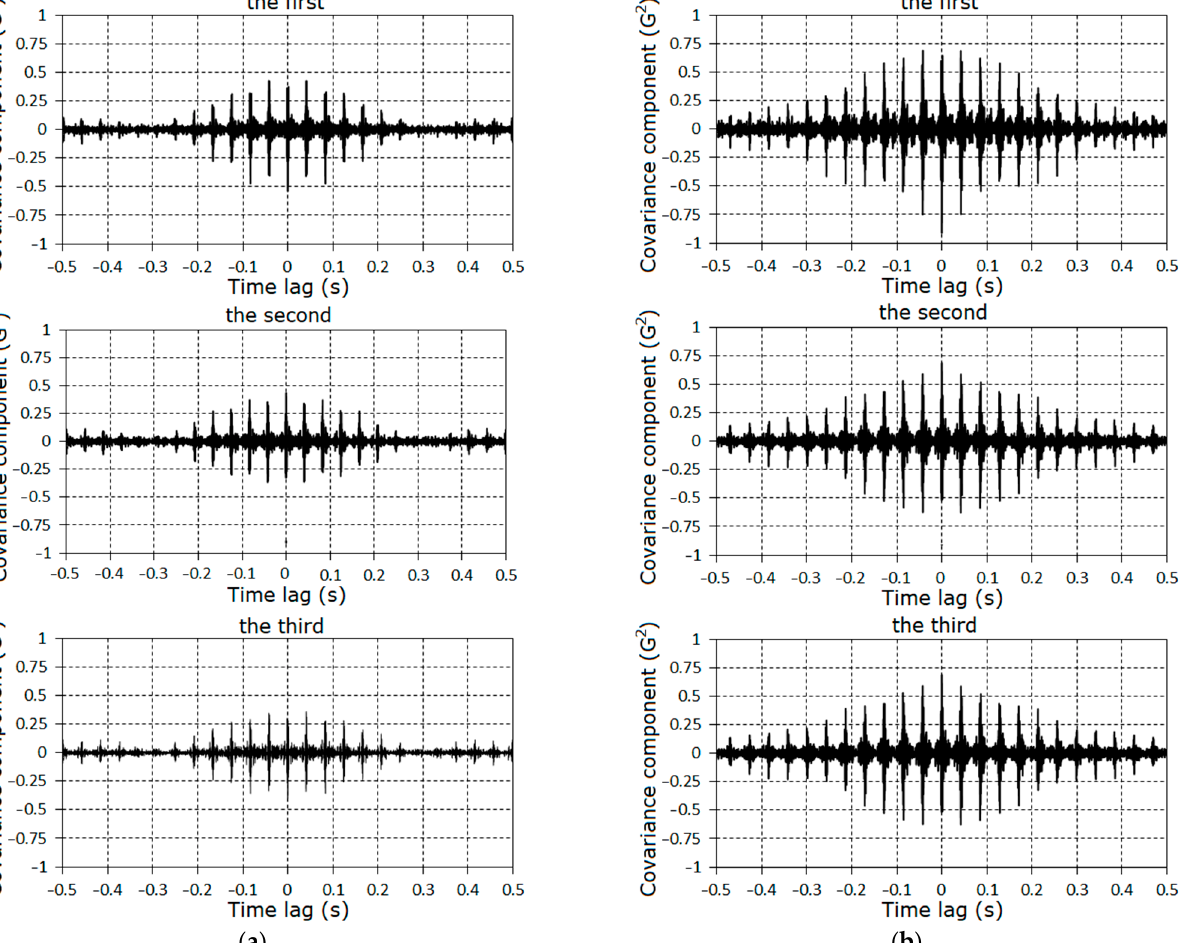
Figure 20. The dependences of the first, second, and third cosine covariance components estimators on the time lag for the second ( a ) and third ( b ) stages.